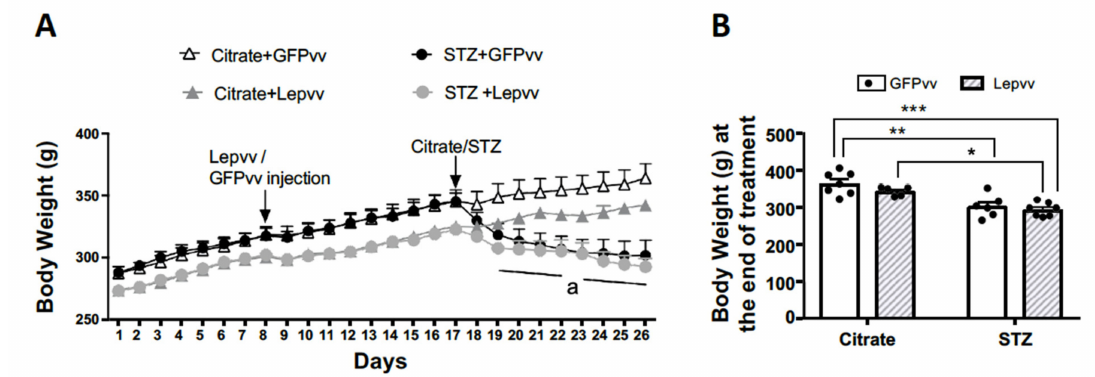
Figure 3. Body weight changes in male rats that were injected with Lepvv or GFPvv on day 8 followed by injection with citrate buffer or STZ (to induced diabetes) on day 17. ( A ) Profile of body weight (g, mean ± SEM) in diabetic and non-diabetic rats treated with Lepvv or GFPvv. Citrate + GFPvv ( n = 7); STZ + GFPvv ( n = 6); Citrate + Lepvv ( n = 5) and STZ + Lepvv ( n = 7) are represented. Data were analyzed using linear mixed models as described under Statistics. “a” indicates significant difference between diabetic rats that received Lepvv and non-diabetic rats that received GFPvv ( p < 0.0001). Differences between diabetic and non-diabetic animals progressively increased towards the end of observation ( p < 0.05– p < 0.0001). ( B ) Average body weight on the 9th day after STZ/citrate injection (g, mean ± SEM). Data were analyzed by 2-way ANOVA followed by Tukey’s multiple comparisons test. Diabetic rats lost more weight compared to the GFPvv treated non-diabetic group. Lepvv treatment caused a dramatic reduction in body weight in diabetic animals, which was still less when compared to non-diabetic rats treated with Lepvv. * indicates p < 0.05; ** p < 0.01 and *** p <